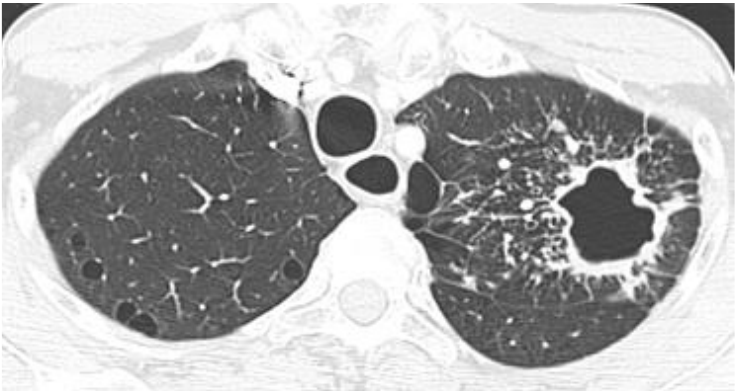
Figure 8. Chronic histoplasmosis infection. CT axial image depicts a spiculated cavity with thick walls in the left upper lobe.